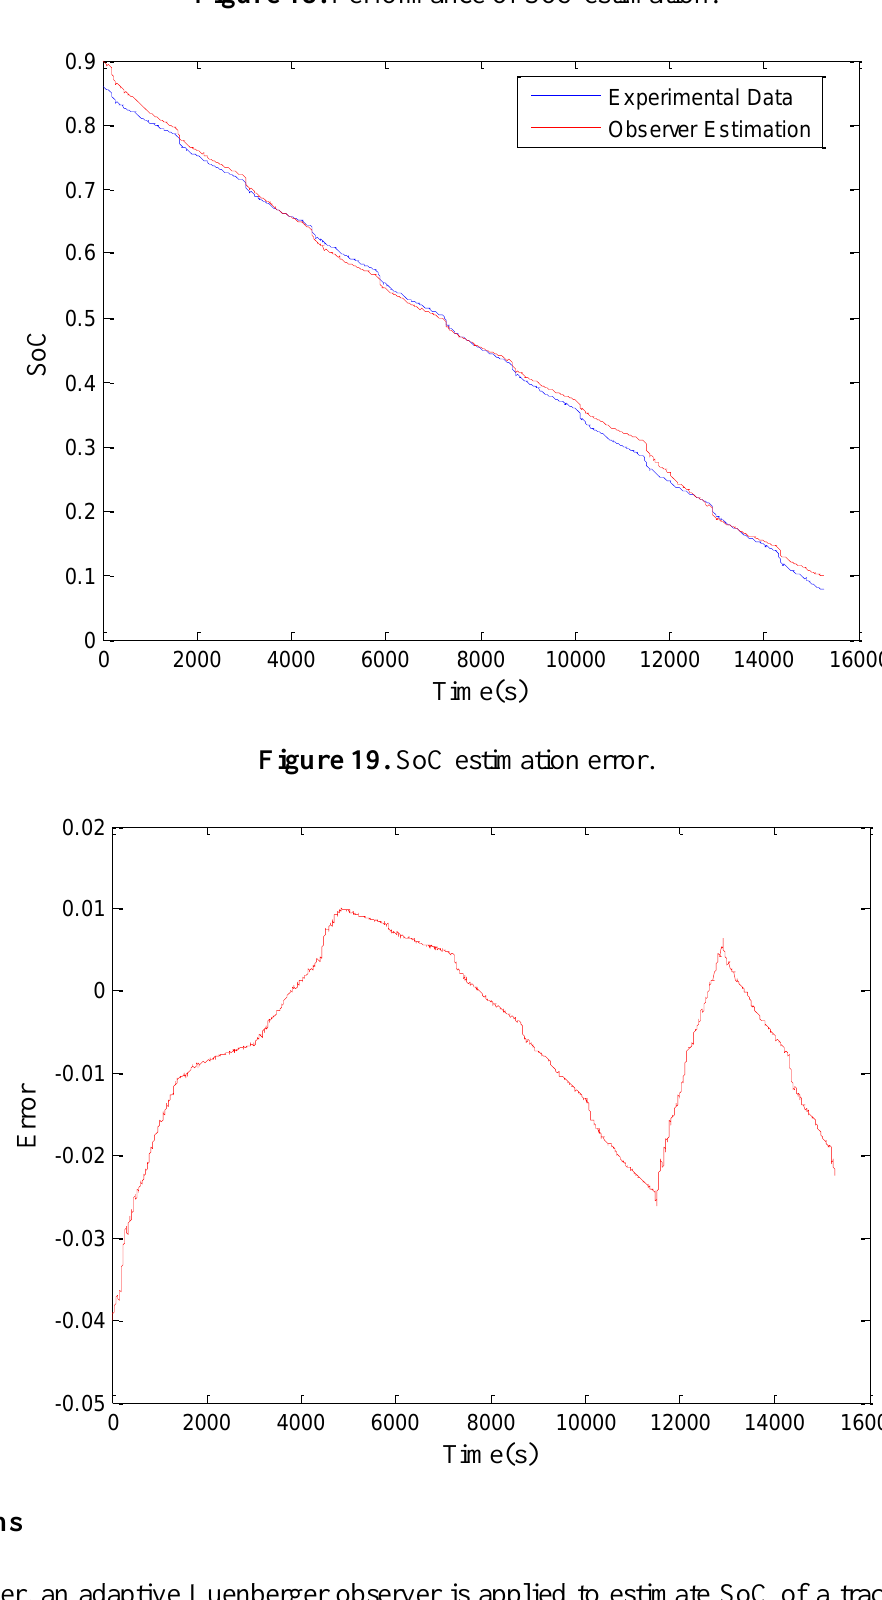
Figure 18. Performance of SoC estimation.